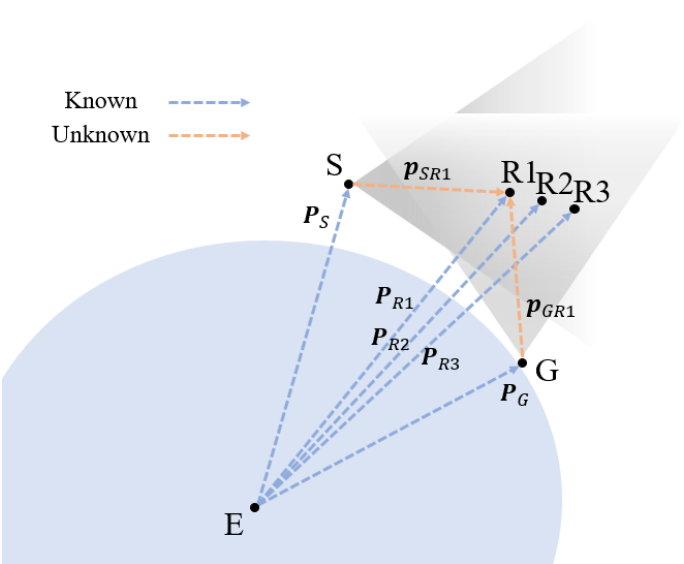
Figure 7. Illustration of simulated multi-site observation of RADARSAT constellation